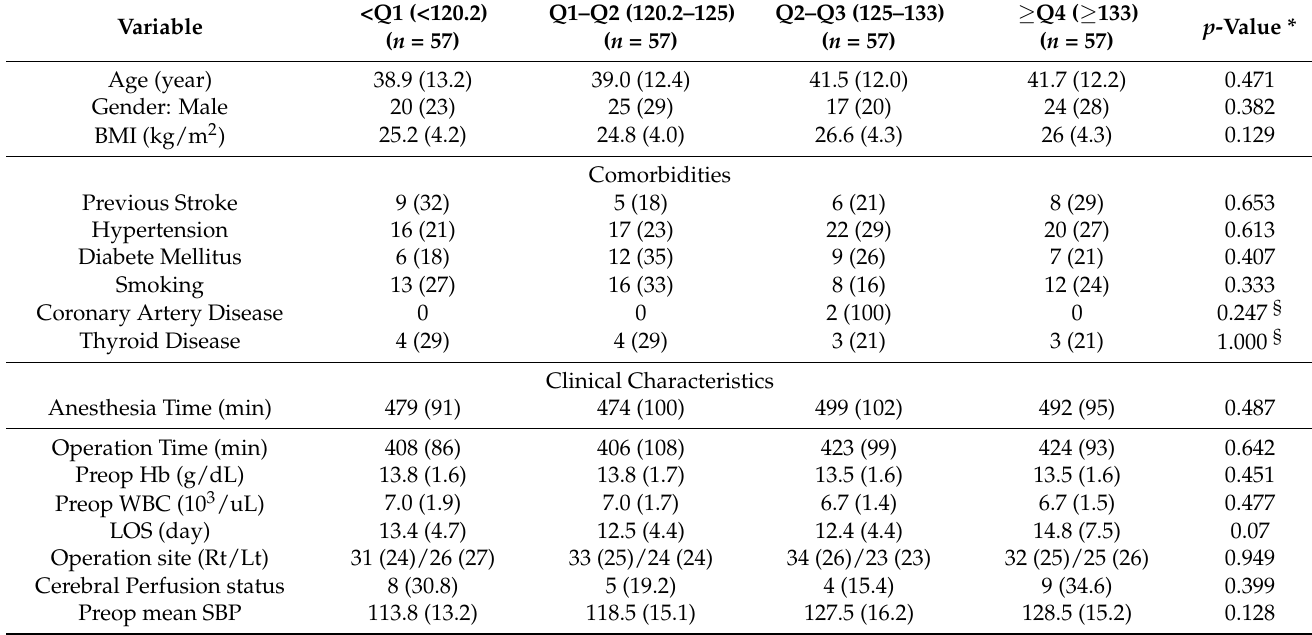
Table 1. Comparison of baseline characteristics by SBP mean